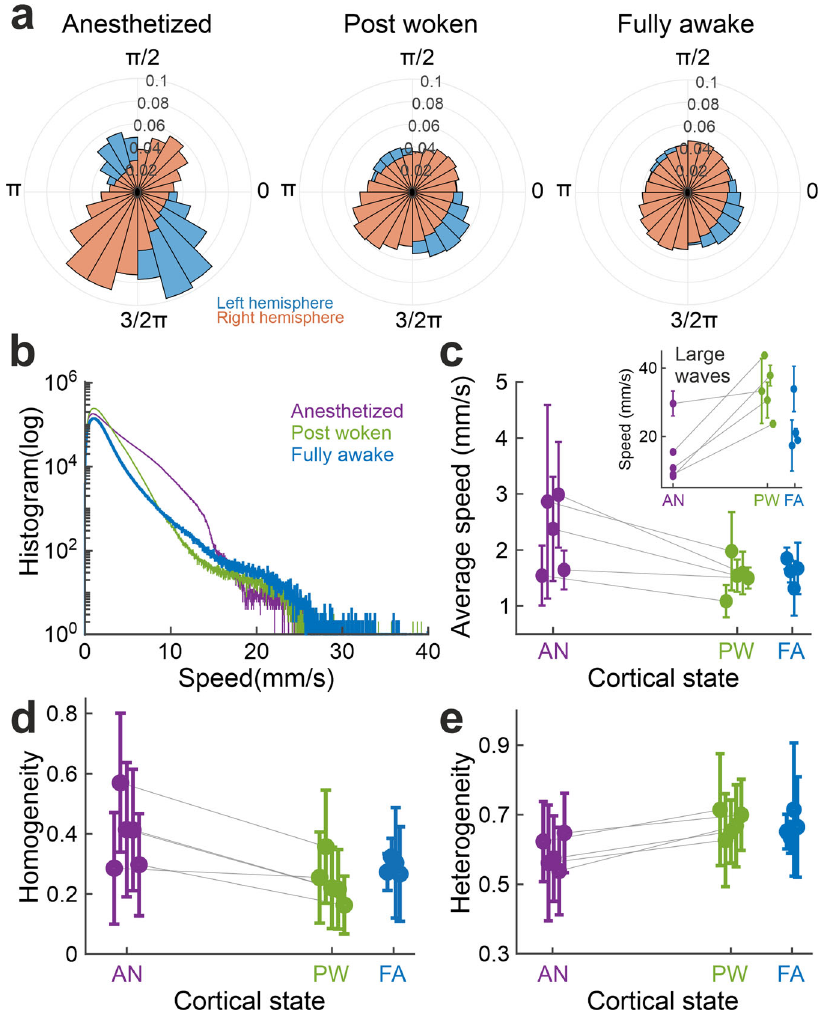
Fig. 2 | Wakefulness alters the direction and speed of the waves. a Angle his- togram of wave propagation directions for each hemisphere over one 3-min trial from a representative mouse at different brain states. b Distribution of the instantaneouswavepropagationspeedoverthetrialsin a . c AveragespeedofPVFs at different brain states. Inset: Average speed of large waves. d Homogeneity of